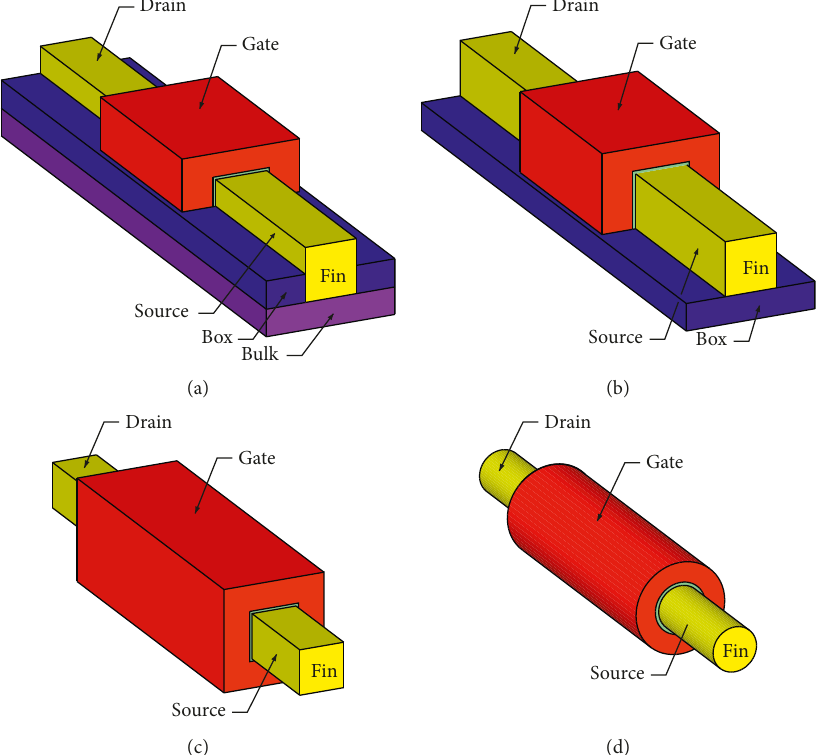
Figure 2: Different types of SOI devices: (a) triple-gate FinFET on Bulk Si, (b) triple-gate FinFET on SOI, (c) quadruple-gate-all-around FET, and (d) surrounding-gate-all-around FET (nanowire